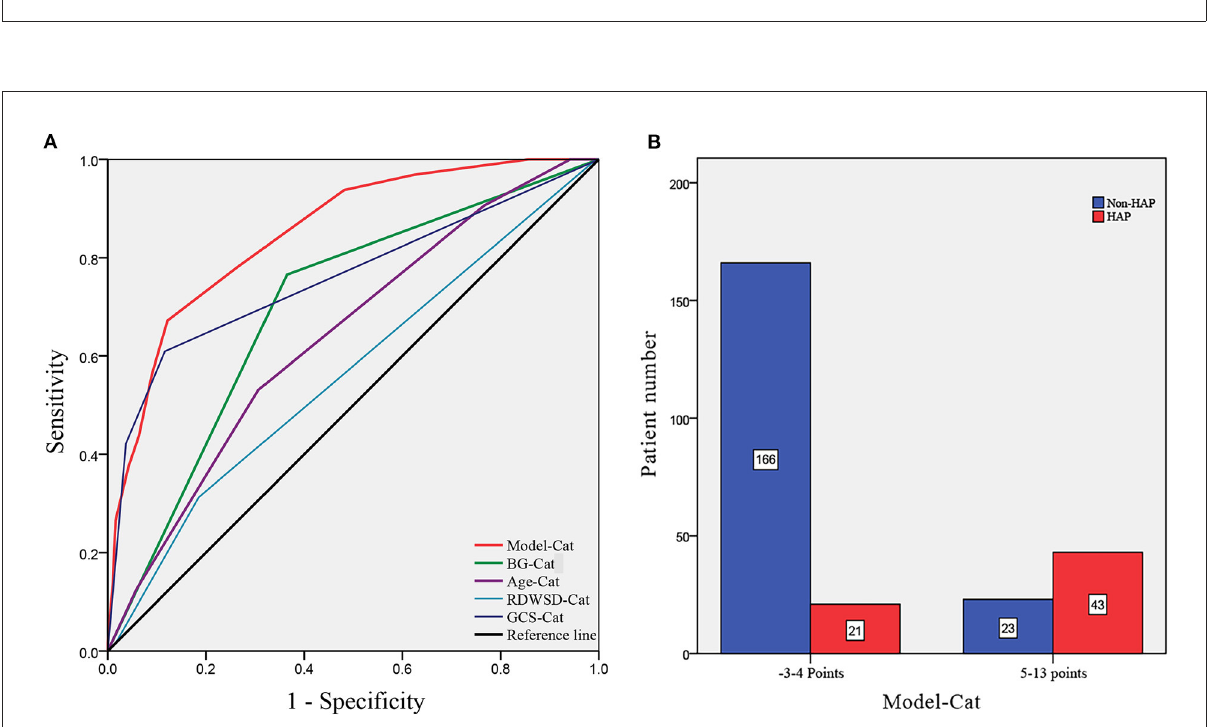
FIGURE4 ROC analysis of the Model-Cat and risk level classification. (A) AUCs of the Model-Cat, BG-Cat, Age-Cat, RDWSD-Cat, and GCS-Cat were 0.850, 0.700, 0.641, and 0.564, and 0.760, respectively. (B) Patient numbers are classified as low-risk level ( − 3 to 4 points) and high-risk level (5–14 points). Model-Cat, predictive model using risk factor category; Glu-Cat, blood glucose ( > 7.22 mmol/L) category; Age-Cat, age category; RDWSD-Cat, red blood cell distribution standard deviation category; GCS-Cat, Glasgow coma scale score